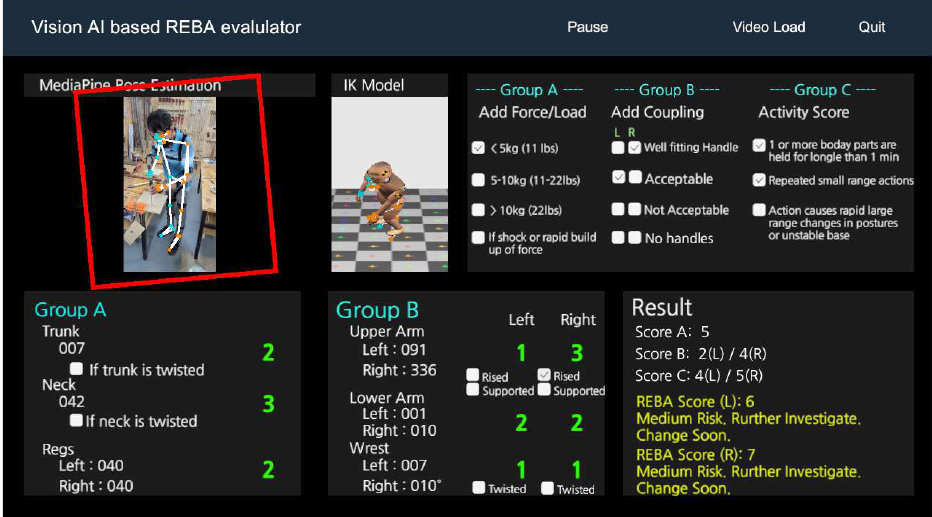
Figure 32. Evaluation of chisel working posture.